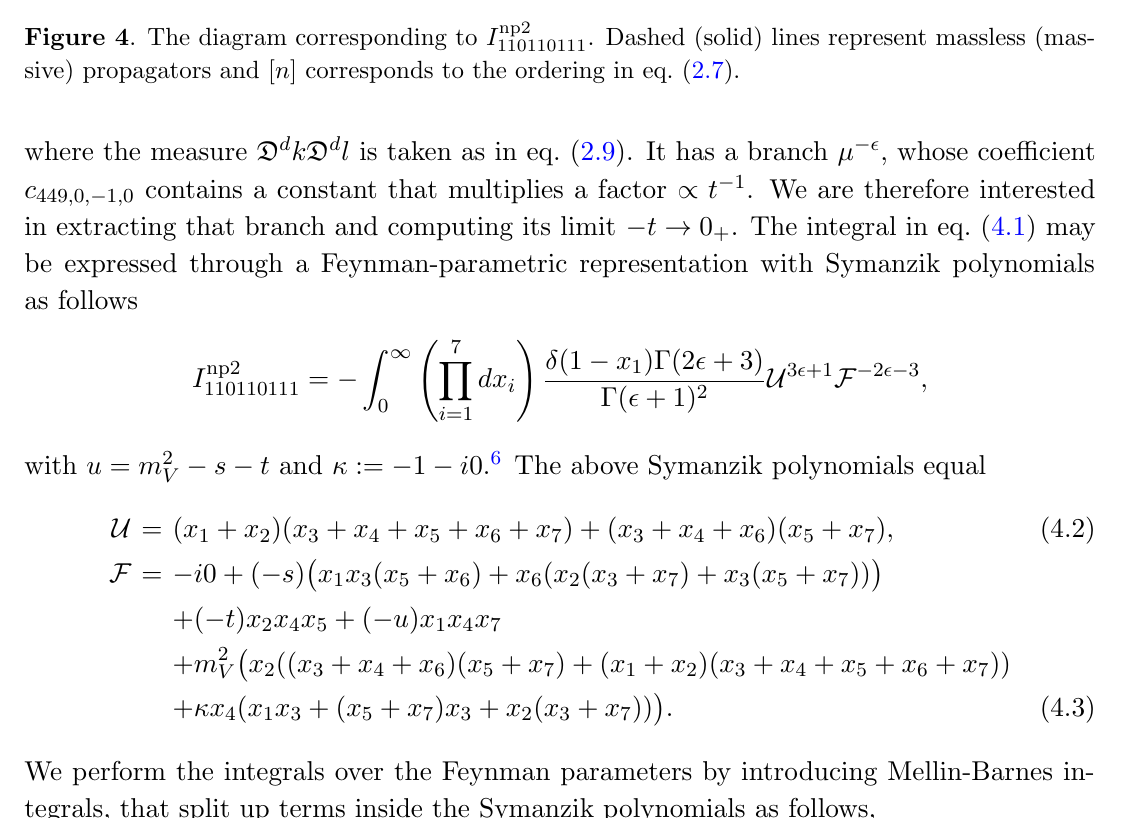
. Dashed (solid) lines represent massless (mas- 110110111